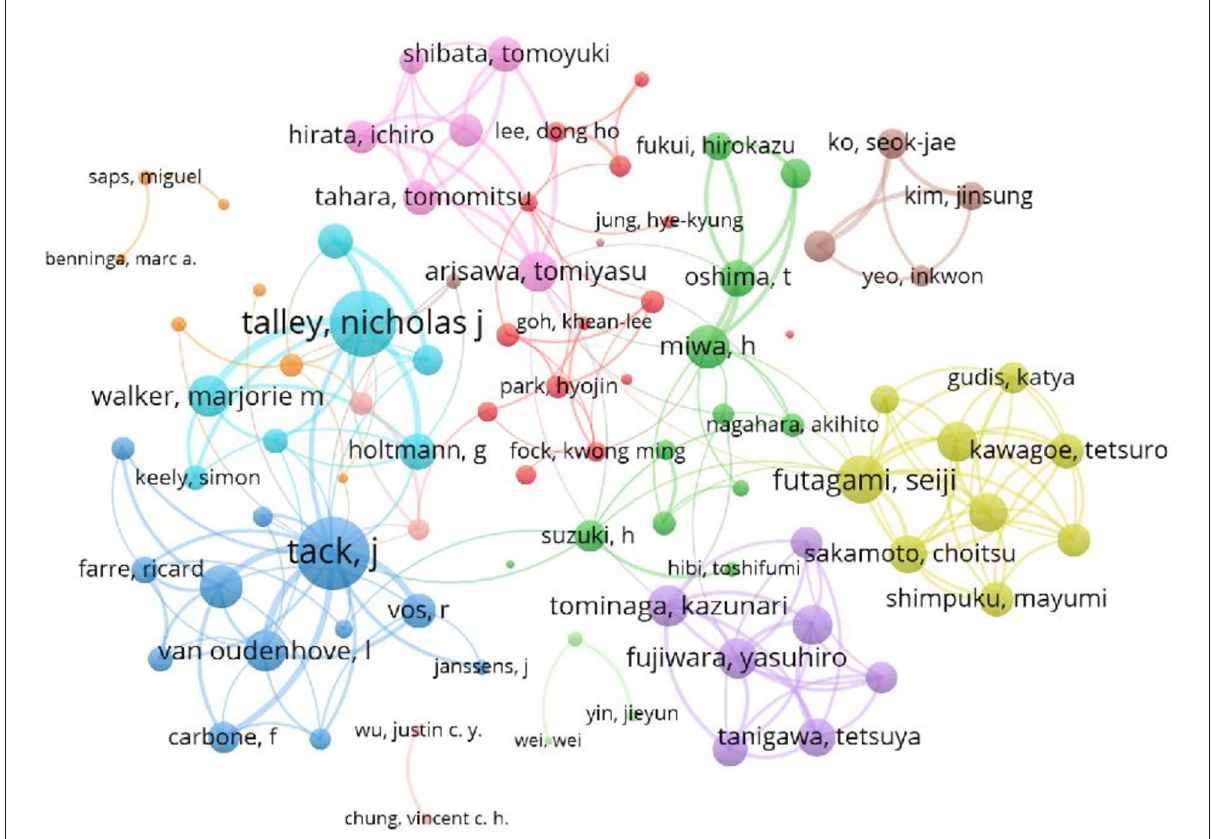
FIGURE3 Co-occurrence of authors on FD. The size of circles was citations. The thickness of the lines indicates the strength of the relationship. The color means different cooperative networks.